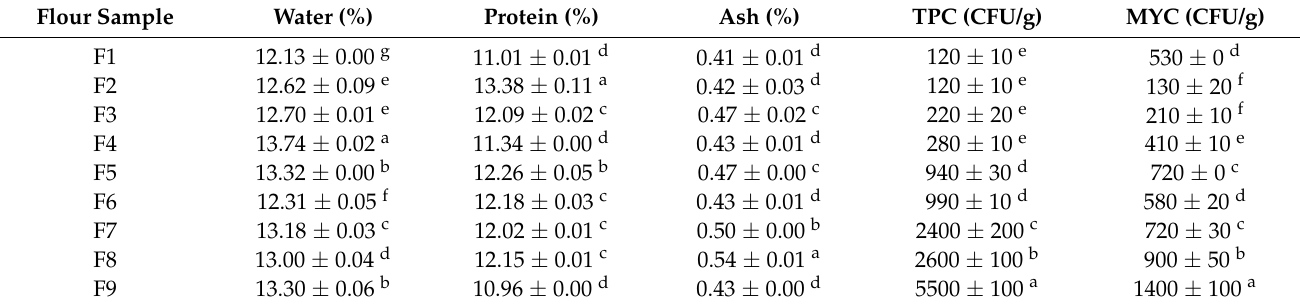
Table 1. Physiochemical parameters and microbial concentration of nine kinds of wheat